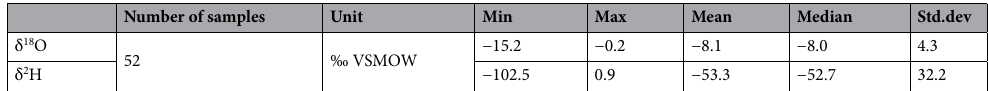
Table 2. Statistical indicators of δ 18 O and δ 2 H in January, February and March for Salar de Atacama study